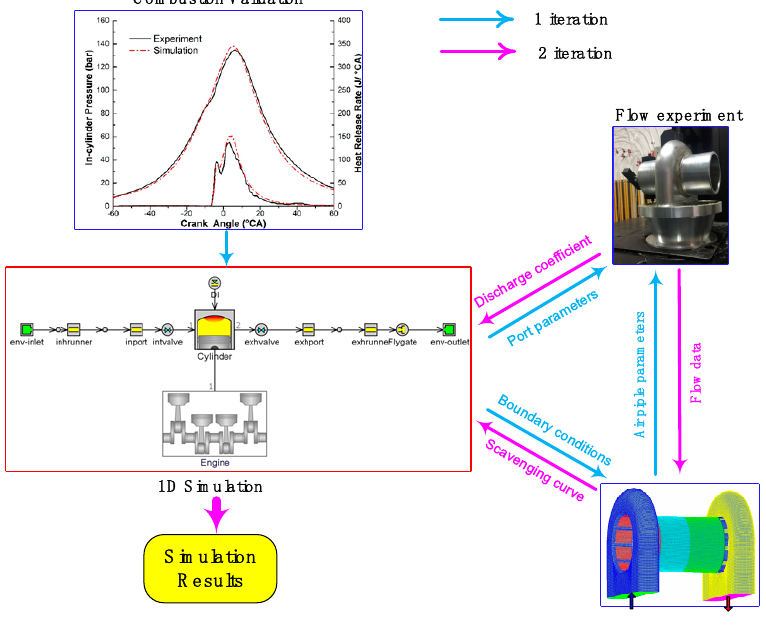
Figure 1. Model validation of the OP2S diesel